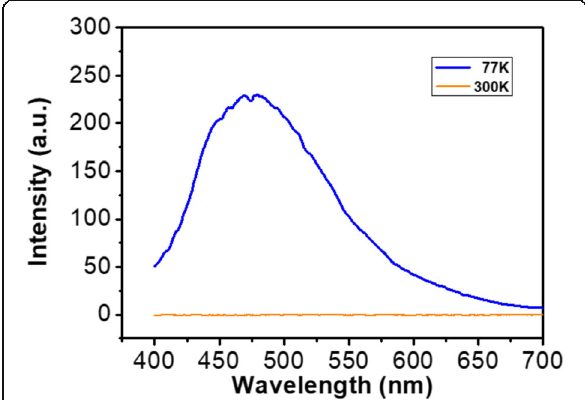
Fig. 7 The room-temperature (300 K) and 77 K emission ( λ ex = 327 nm) spectra of pure La 3 Ga 5.5 Nb 0.5 O 14 powders annealed at 800